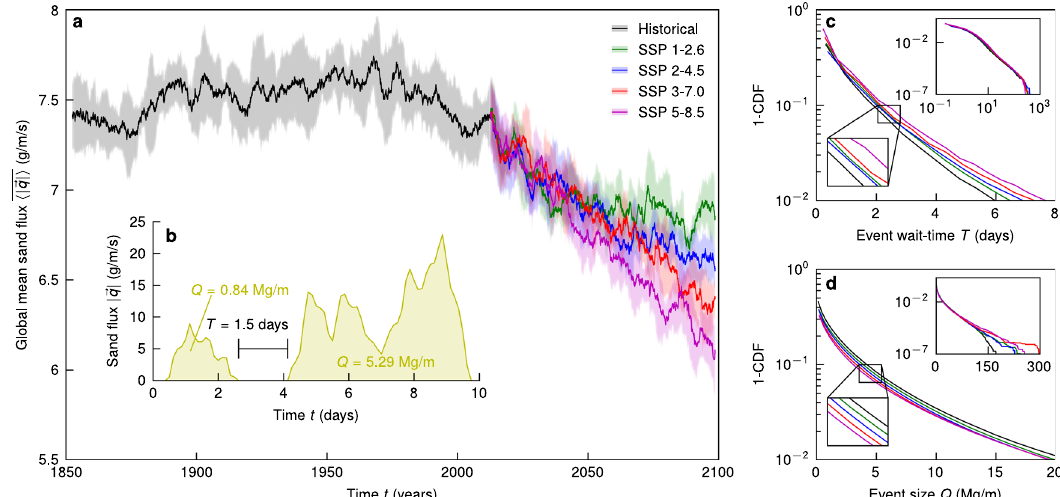
Fig. 2 Historical and SSP global sand fl ux activity. a Modelled time series of the 5-year smoothed globally-averaged sand fl ux magnitude hj q ! ji (g/m/s) for the historical (black) and future SSP (1 – 2.6, green; 2 – 4.5, blue; 3 – 7.0, red; 5 – 8.5, purple) scenarios; ensemble mean (lines) and ± 1 standard deviation (shaded envelopes) are shown. b An example sand fl ux magnitude j q ! j (g/m/s) time series (yellow) from the Namib Sand Sea for one tile in one ensemble member de fi ning the event size Q (Mg/m) (shaded yellow areas) and wait-time T (days) (horizontal black line). The global Magnitude-Frequency plot for each scenario (lines colored as in ( a )) of ( c ) T and ( d ) Q up to the 99th percentile with insets top-right showing the full CDFs to the (100 − 10 − 5 )th percentile and bottom-left to compare scenarios at the 90th